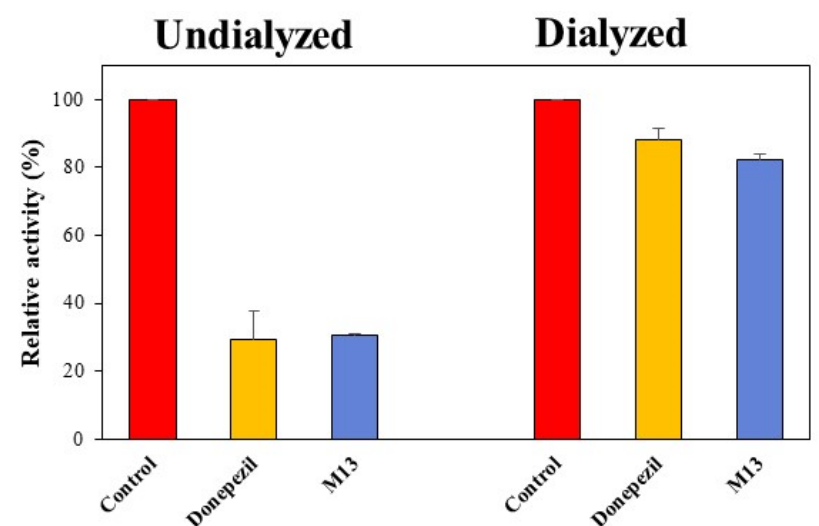
Figure 4. Recovery of BChE inhibition by M13 using the dialysis method.